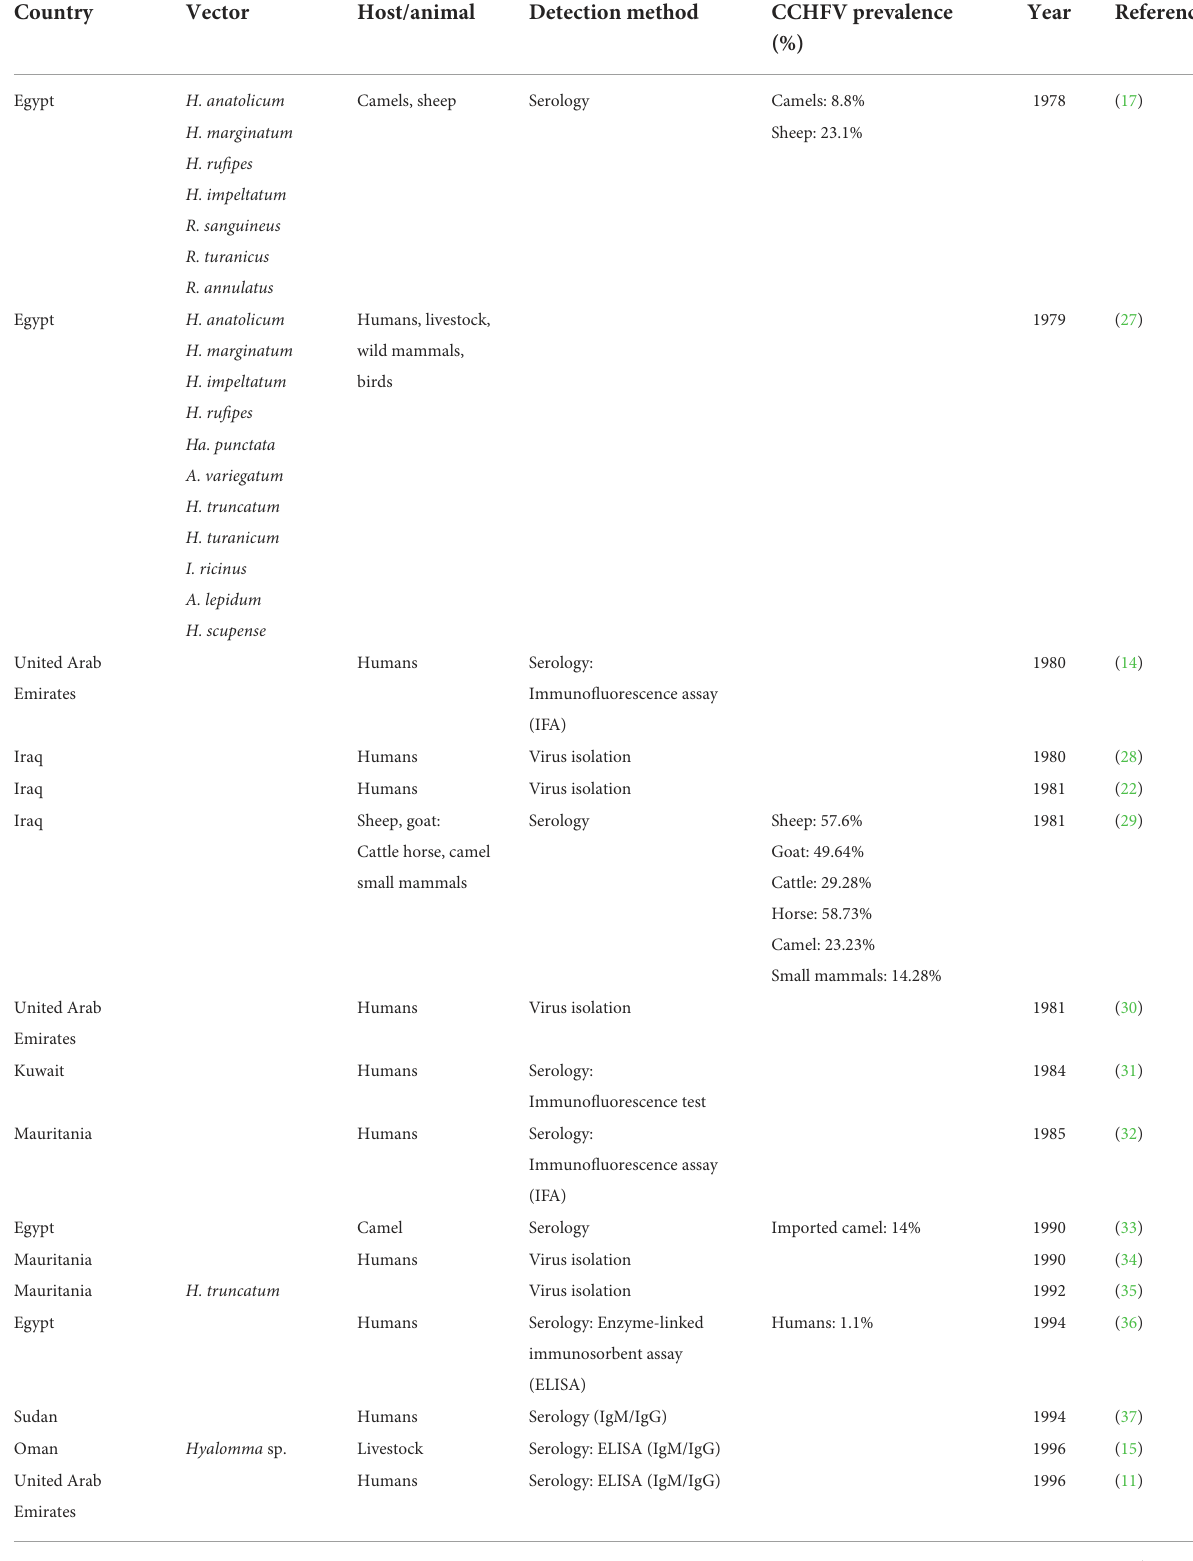
TABLE 1 Chronological reporting of CCHFV vectors, hosts, and human cases in the Arab world from 1978–2021.